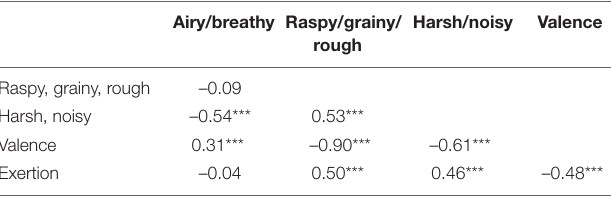
TABLE 1 | Pearson’s correlation coefficients among ratings of perceived valence, playing exertion, airy/breathy , raspy/grainy/rough , and harsh/noisy